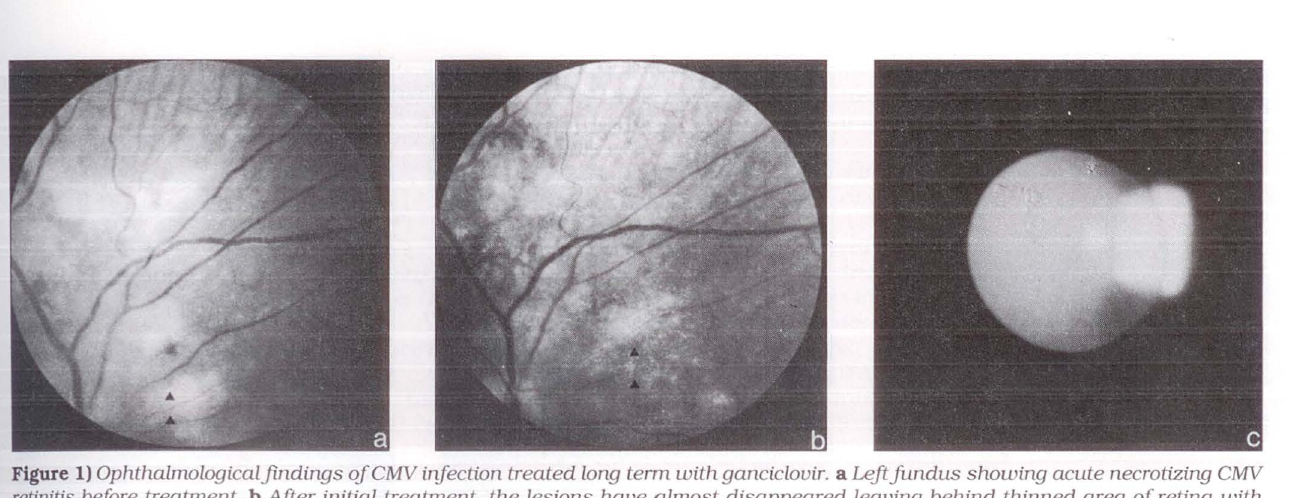
Figure 1) Ophthalmological findings ofCMV infection treated long term withganciclovir. a Leftfundus showing acute necrotizing CMV retinitis before treatment. b lifter initial treatment, the lesions have almost disappeared leaving behind thinned area of retina with sclerotic vessels. c Right lens showing early vesicular posterior lenticular changes attributable to the chronic use of